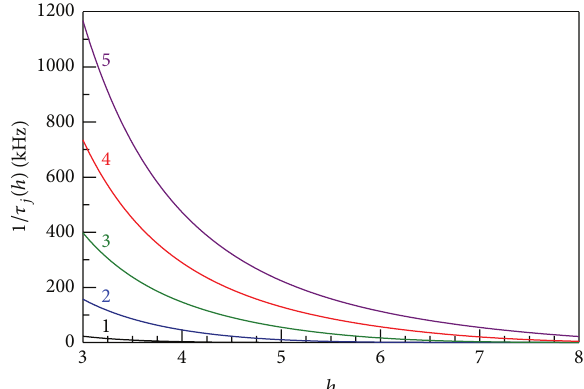
Figure 5: The prediction for the neutron count for the new waveguidewith2Dexponentialroughnesswithparameters 𝑟 = 0.65 , 𝜂 = 1.02